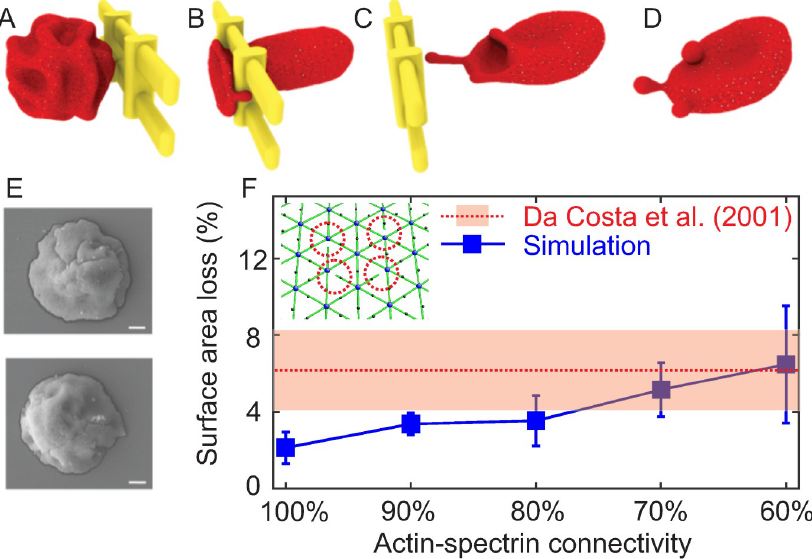
Fig 2. (A–D) Four sequential snapshots of a reticulocyte passing through IES driven by a pressure gradient of 10 Pa μ m − 1 . The redundant membrane surface on the reticulocyte is removed through shedding vesicles. The reticulocyte develops to a biconcave shape after the passage of IES. (E) Two examples of cord blood reticulocytes with medium (top) and high (bottom) level of CD71 observed using scanning electron microscopy. Figure adopted from [65]. (F) Summary of the fraction of surface area loss from reticulocytes with various levels of actin-spectrin connectivity after passing through IES. The error bars are computed based on pressure gradient values of 5, 8, 10, 15 and 20 Pa μ m − 1 . The red dashed line highlights the average fraction of reduced surface area of reticulocytes during their maturation as reported by Da Costa et al. [42]. The red area represents the standard deviation of the